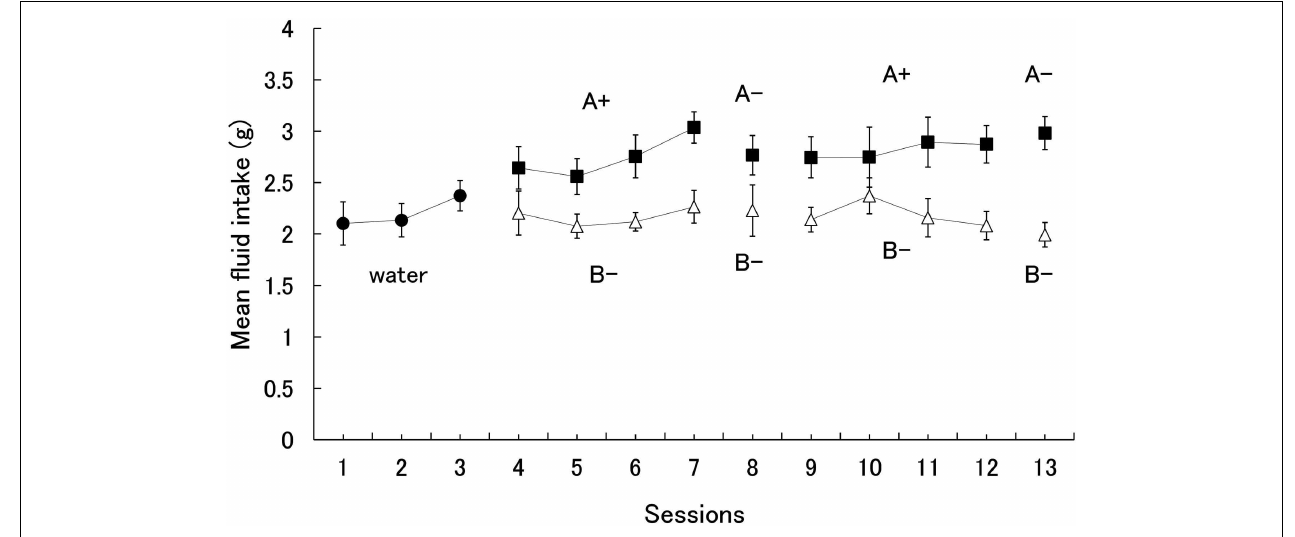
FIGURE 1 | Mean intake of each stimulus during acquisition and probe test of conditioned flavor preference. Error bars indicate standard errors.